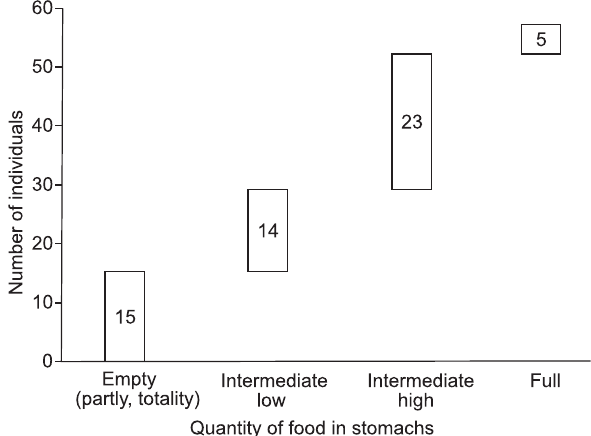
Figure 2. Waterfall chart showing the degree of repletion of the stomachs of Monodelphis glirina individuals.